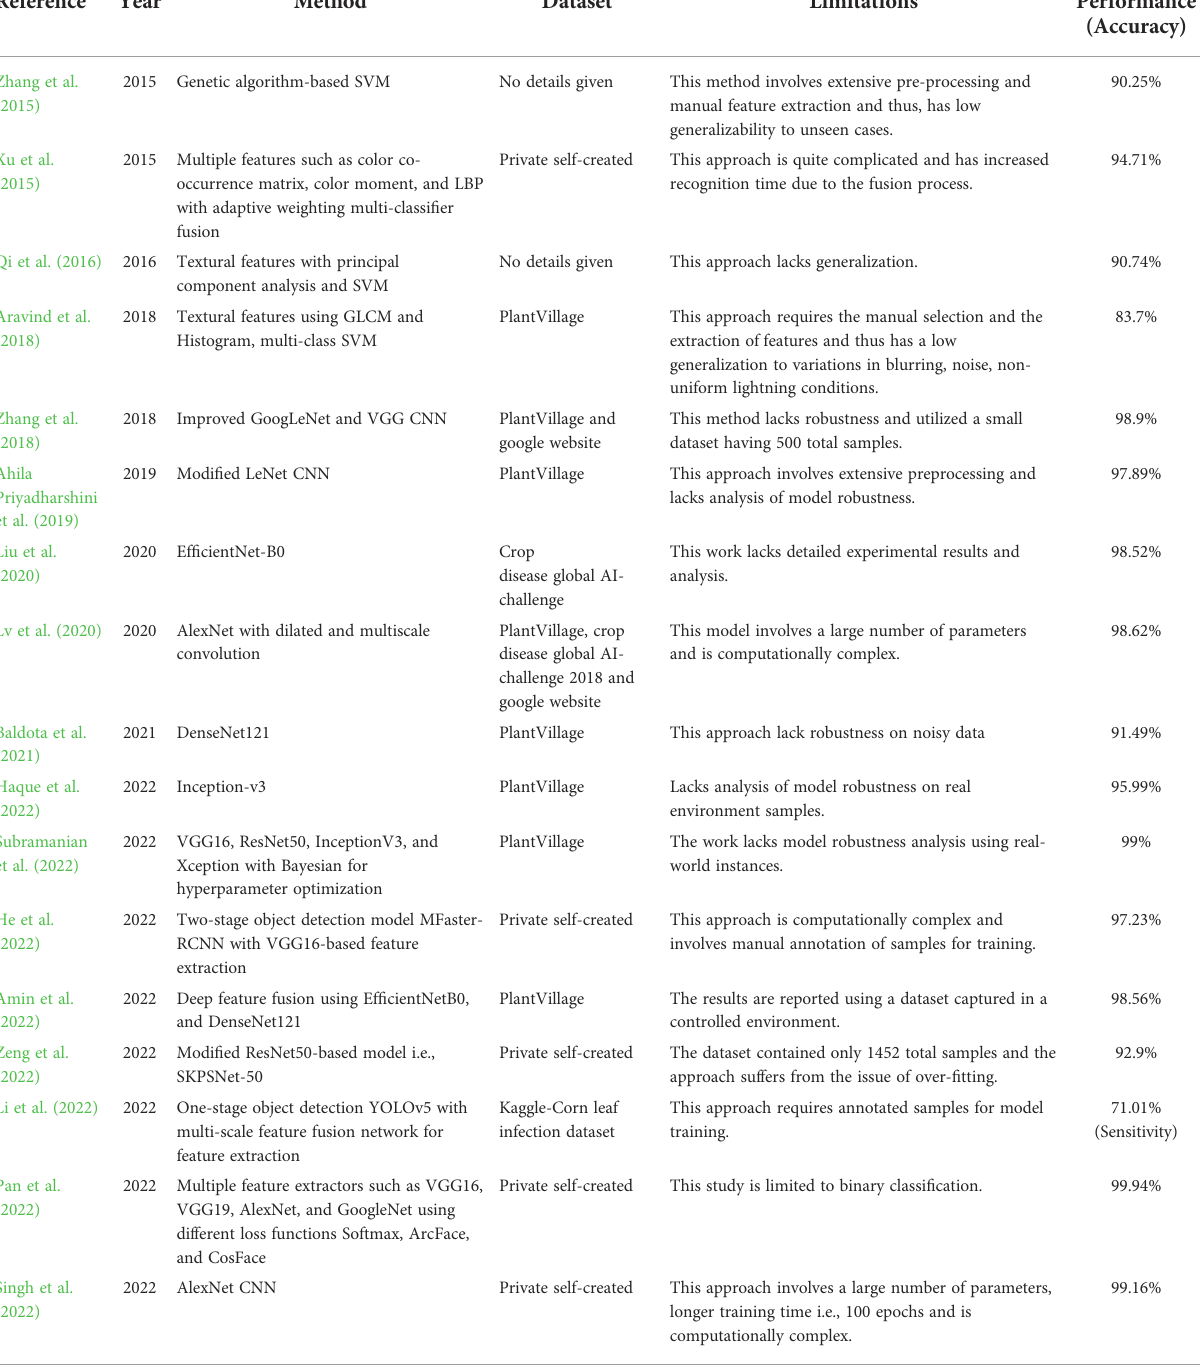
TABLE 1 Comparison of existing